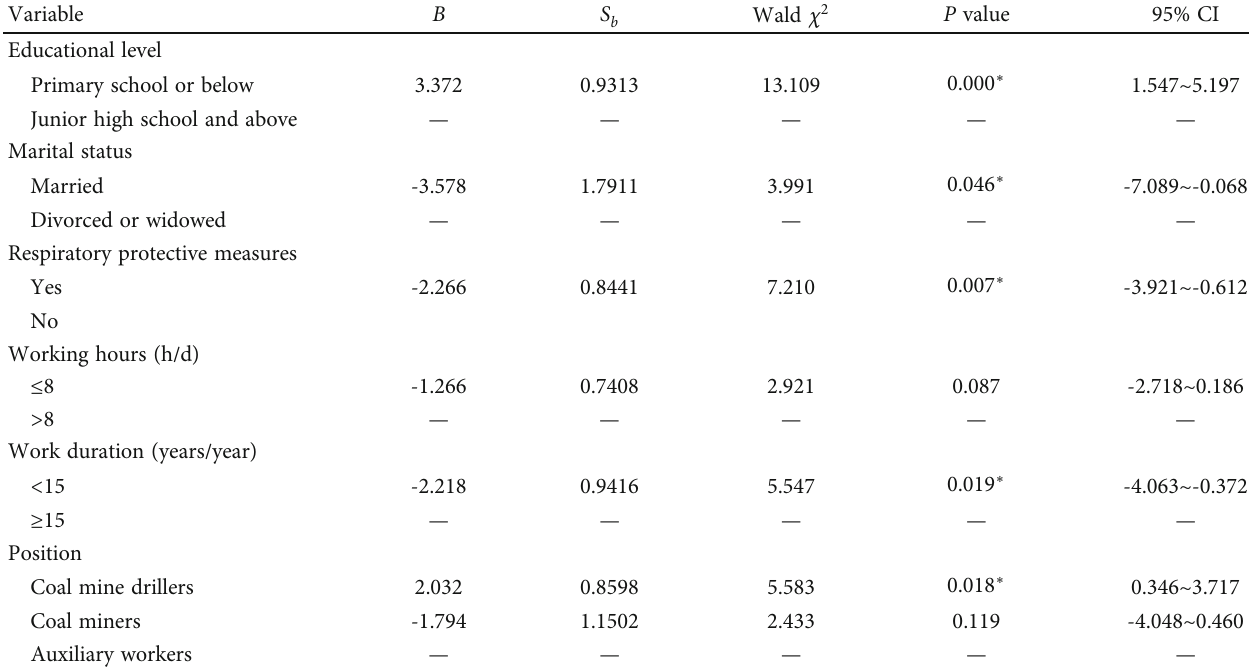
Table 6: Analysis of risk factors for coal workers ’ pneumoconiosis.